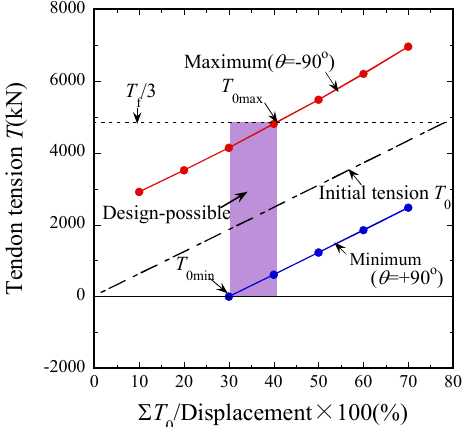
The maximum and minimum tendon tension dependencies on the initial tension and a design-possible area ( L : D p : H p = 30 m: 6 m: 23 m, tendon No. 1, under storm